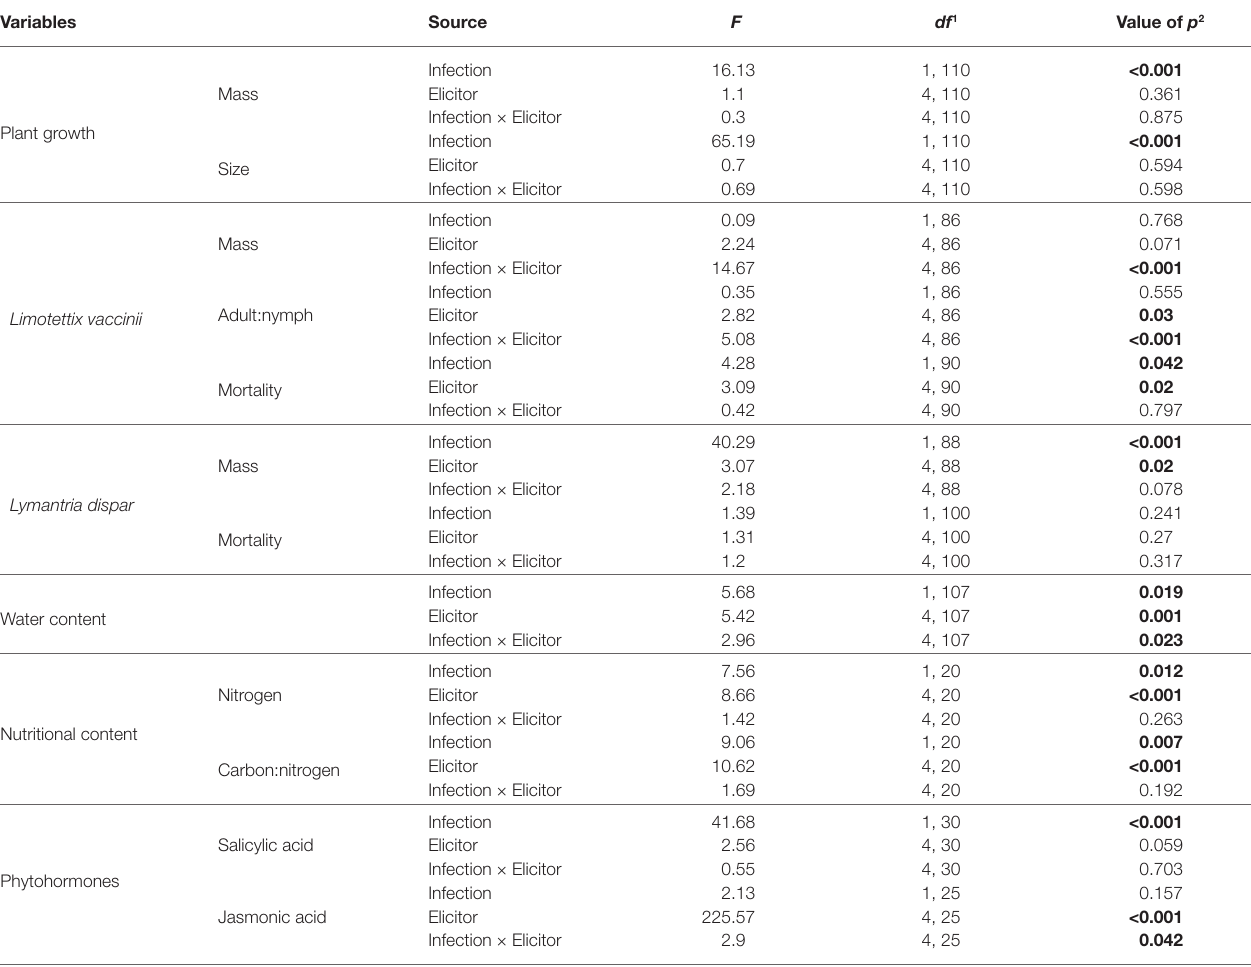
TABLE 3 | Results of two-factor ANOVA on the effects of phytoplasma infection and chemical elicitors on plant traits and insect performance. Variables